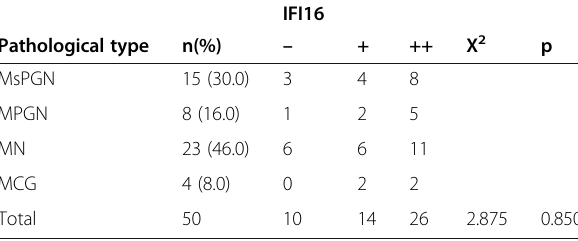
Table 6 Expression of IFI16 was positively correlated with Caspase-1 and IL-1ß in HBV-GN